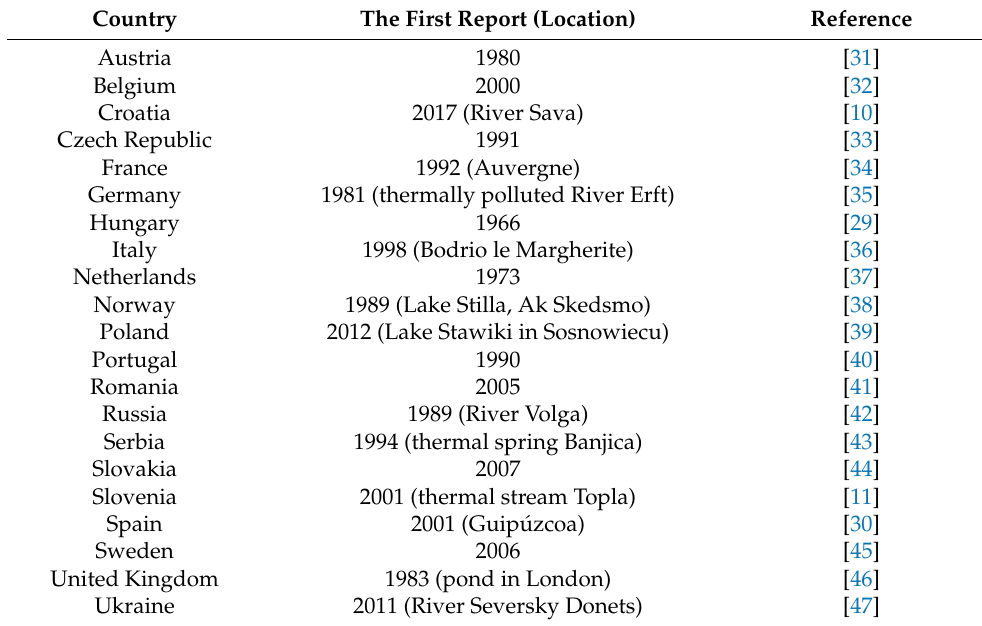
Table 1. Distribution of P. stratiotes within European countries and year of the first report. Country The First Report